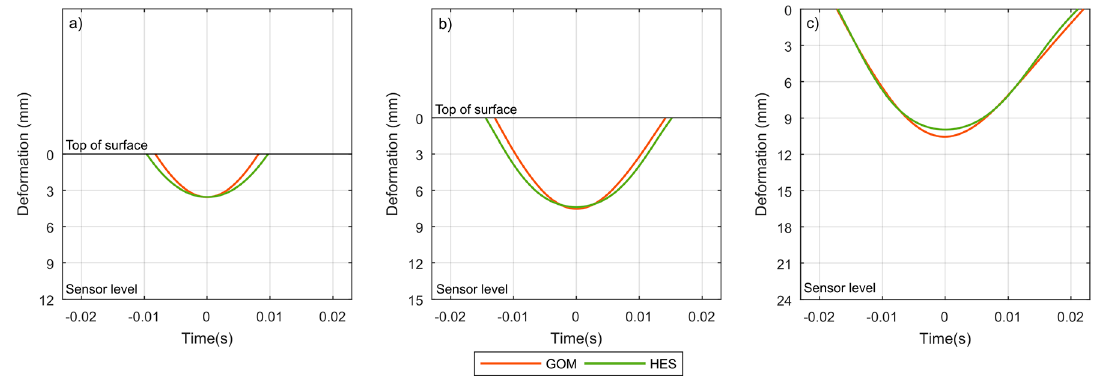
Figure 6. Typical sample deformation profiles (55 mm drop height) for the (HES) and GOM systems for ( a ) RS, ( b ) SP1, and ( c ) SP2. The y-axis range is the sample thickness, from the top to the sensor board